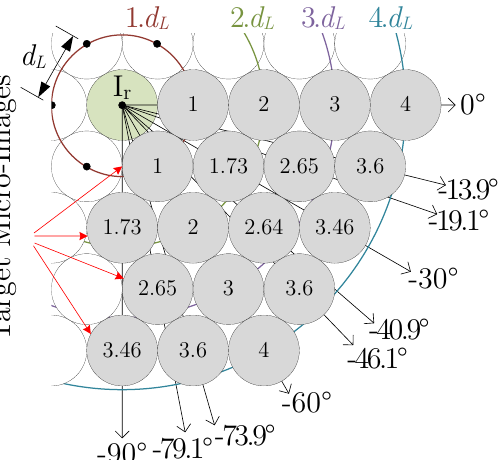
Figure 9. Micro-images grid including reference and target micro-images placed at different base- line